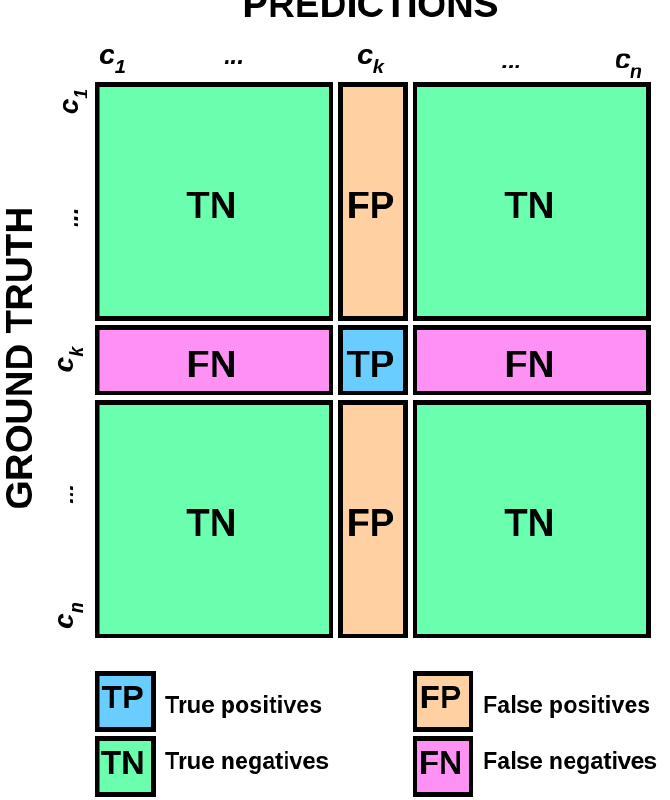
Figure 11. The transformation of a multi-class confusion matrix into a binary confusion matrix for class c k . The macro- F 1 score is calculated as the arithmetic mean of F 1 scores of all classes